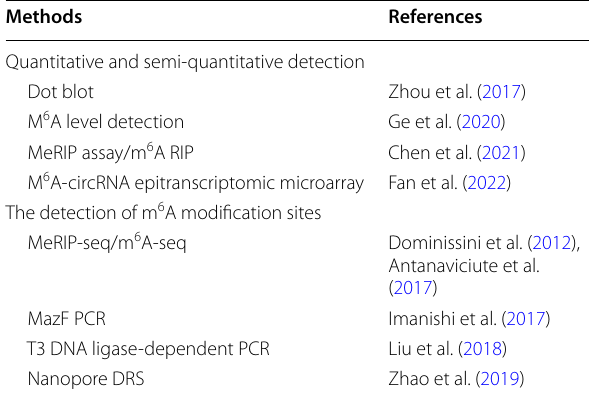
Table 1 Detection methods for m 6 A-modified circRNAs Methods